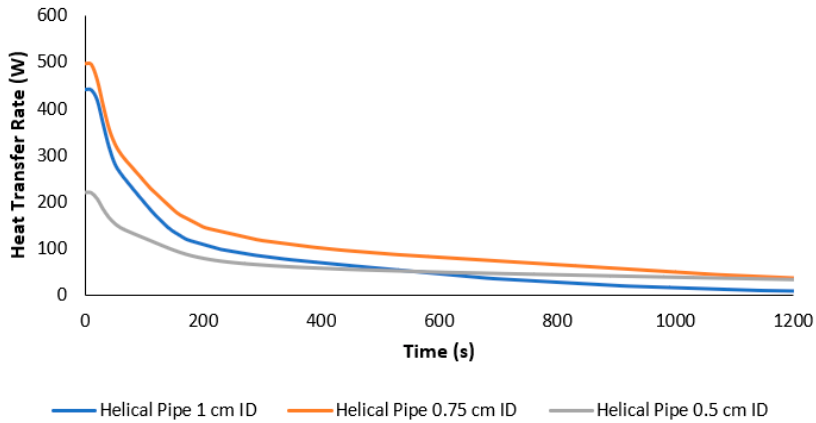
Figure 14. Outlet temperature vs. time for the helical pipe configuration with various IDs.